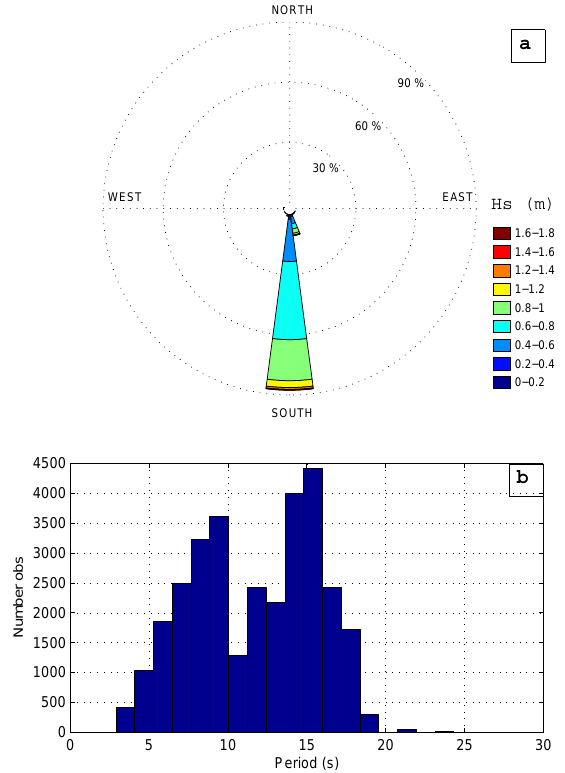
Figure 2. Wave conditions for the south shore of O’ahu as measured by the Kilo Nalu observatory. (a) shows the wave rose with fre- quency of occurrence (%) per wave significant height ( H s ) and di- rection classes – the direction was binned in 10 ◦ classes, and (b) the histogram of wave peak period. One can see a large prevalence of waves from the south, with H s usually under 1m, and two main peak periods around 10 and 15s.